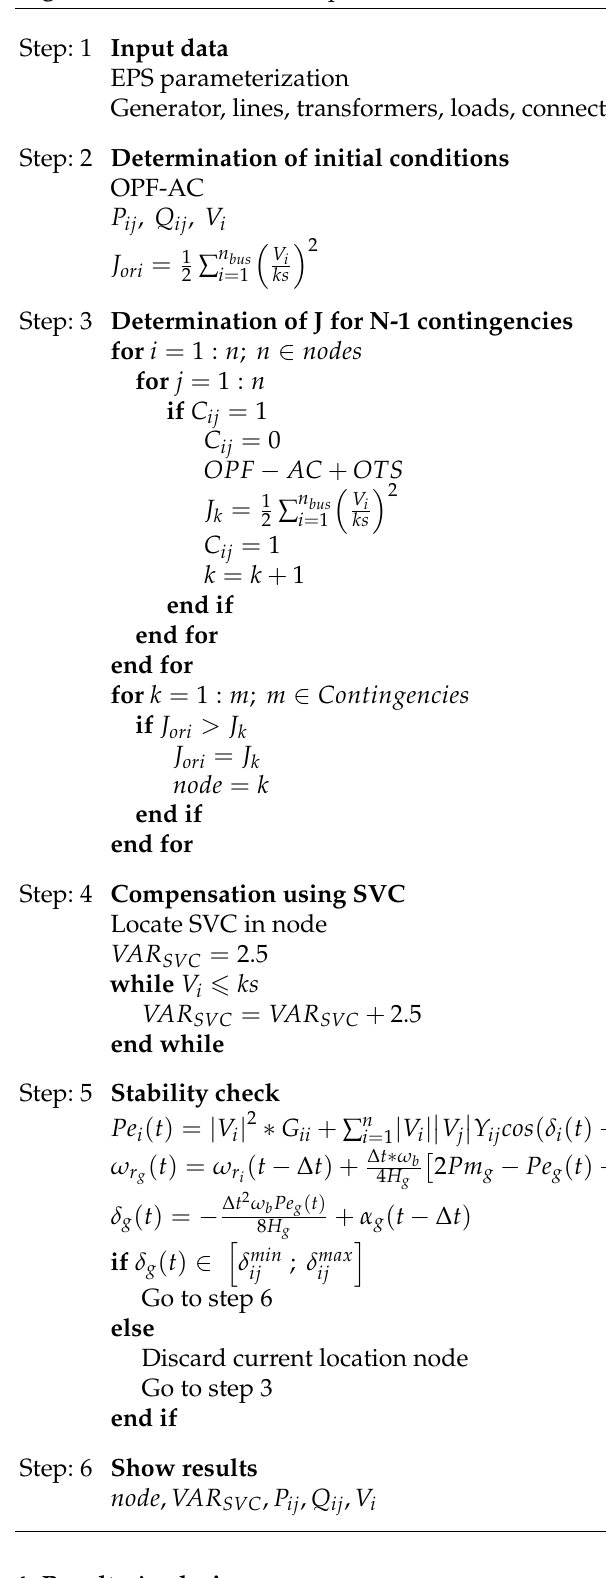
Algorithm 1 Heuristics for optimal SVC